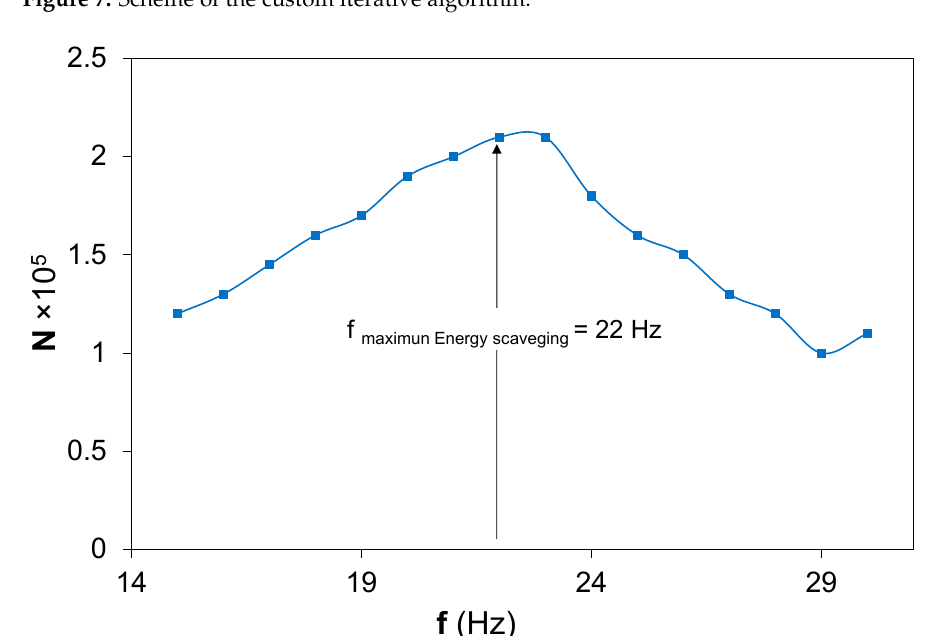
Figure 8. N coefficient calculated from the customized iterative algorithm versus frequency.